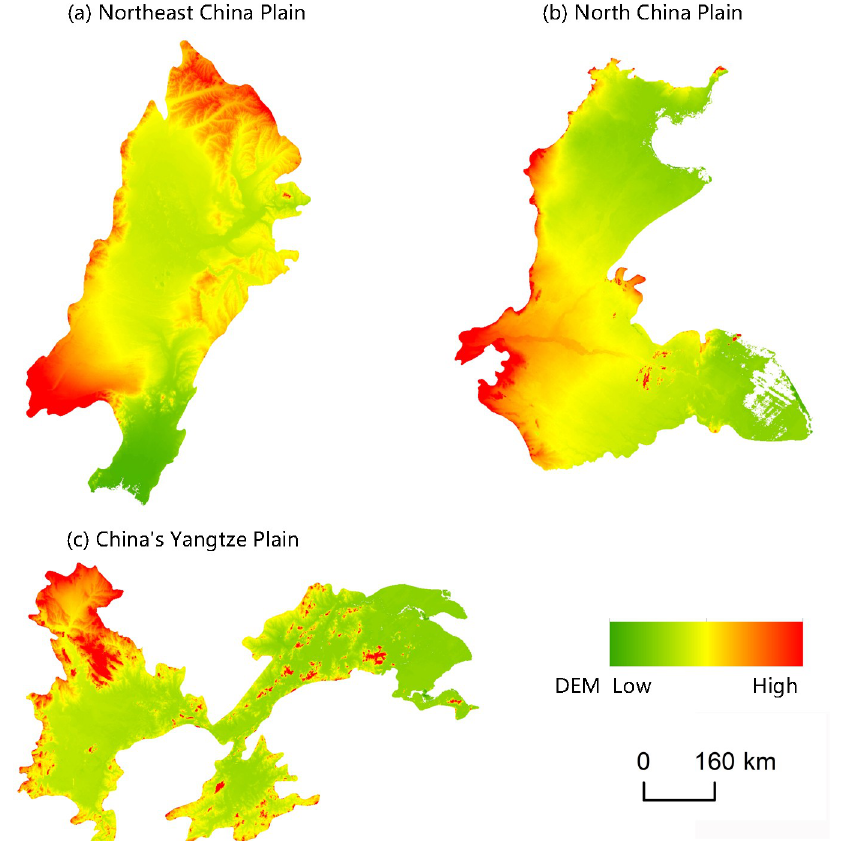
Fig 8. DEM data of the case study areas. DEM data at a resolution of 30 m were provided by the RESDC.